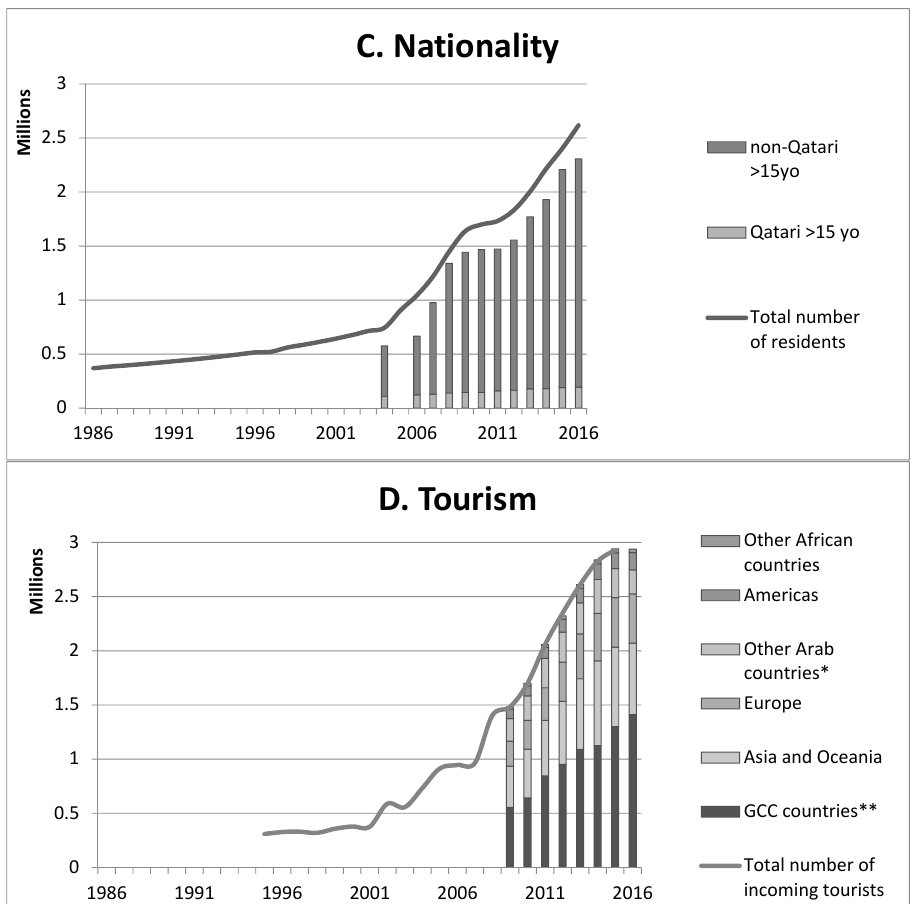
Figure 2. Developments in human demography in Qatar; ( A ) Development over time of the age structure of the population; ( B ) Development over time of the human sex ratio; ( C ) Development over time of the ration Qatari vs. non Qatari; ( D ) Development over time of tourism per country of origin *Other Arab countries: Algeria, Comoros, Djibouti, Egypt, Iraq, Jordan, Lebanon, Libya, Mauritania, Morocco, Palestine, Somalia, Sudan, Syria, Tunisia, and Yemen. **GCC countries: Bahrain, Kuwait, Oman, Qatar, KSA, and the United Arab